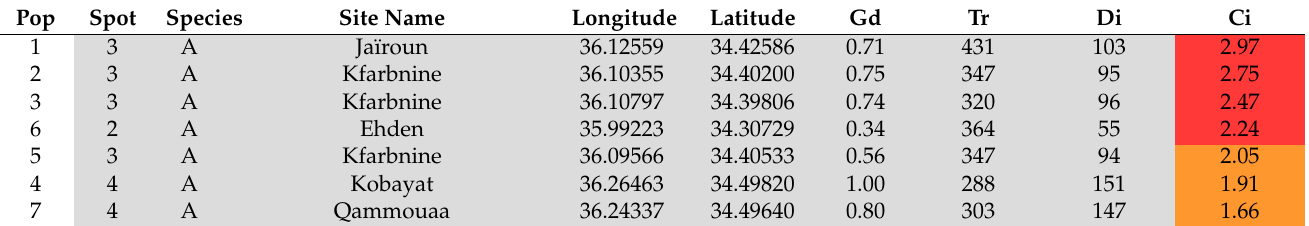
Table 1. Location with latitude and longitude of populations (Pop) of Abies cilicica (Species A), Cedrus libani (Species C), and Juniperus excelsa (Species J) with their site name, genetic diversity (Gd), terrain ruggedness (Tr) in the area where they occur and the distance (Di) between the mean of their current climate range and a hypothetical expected warmer (+2 ◦ C) and drier ( − 20% precipitation) climate. Colors correspond to quantiles of the conservation index (Ci) for each species, which represents a gradation of conservation priority from very high (red) to low (green, see Figure